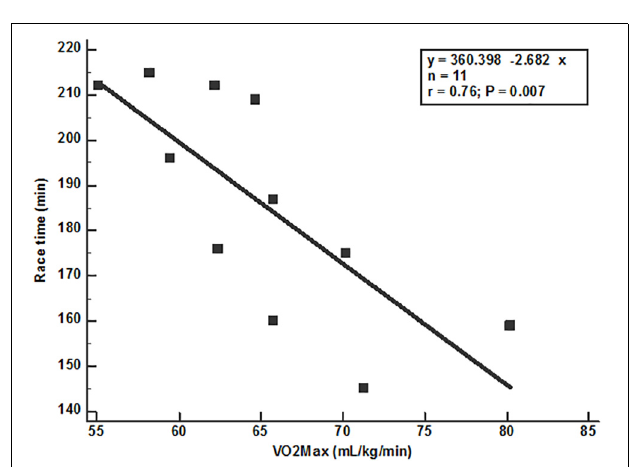
FIGURE 2 | Correlation between race time and vVO 2 max.